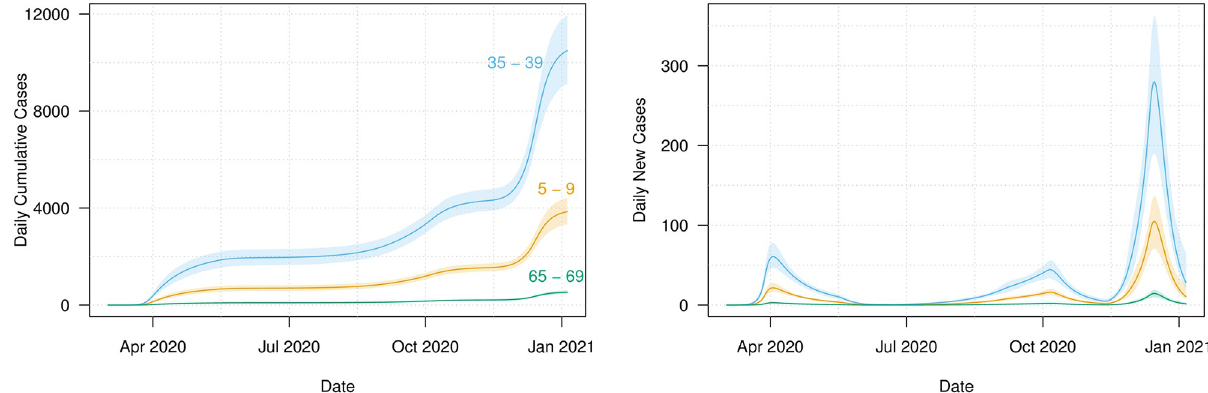
Fig 5. Case numbers for selected age classes obtained from the forward simulations of the SEIR with 95% intervals from bootstrapping. The age classes are 5–9 (orange), 35–39 (blue), and 65–69 (green).